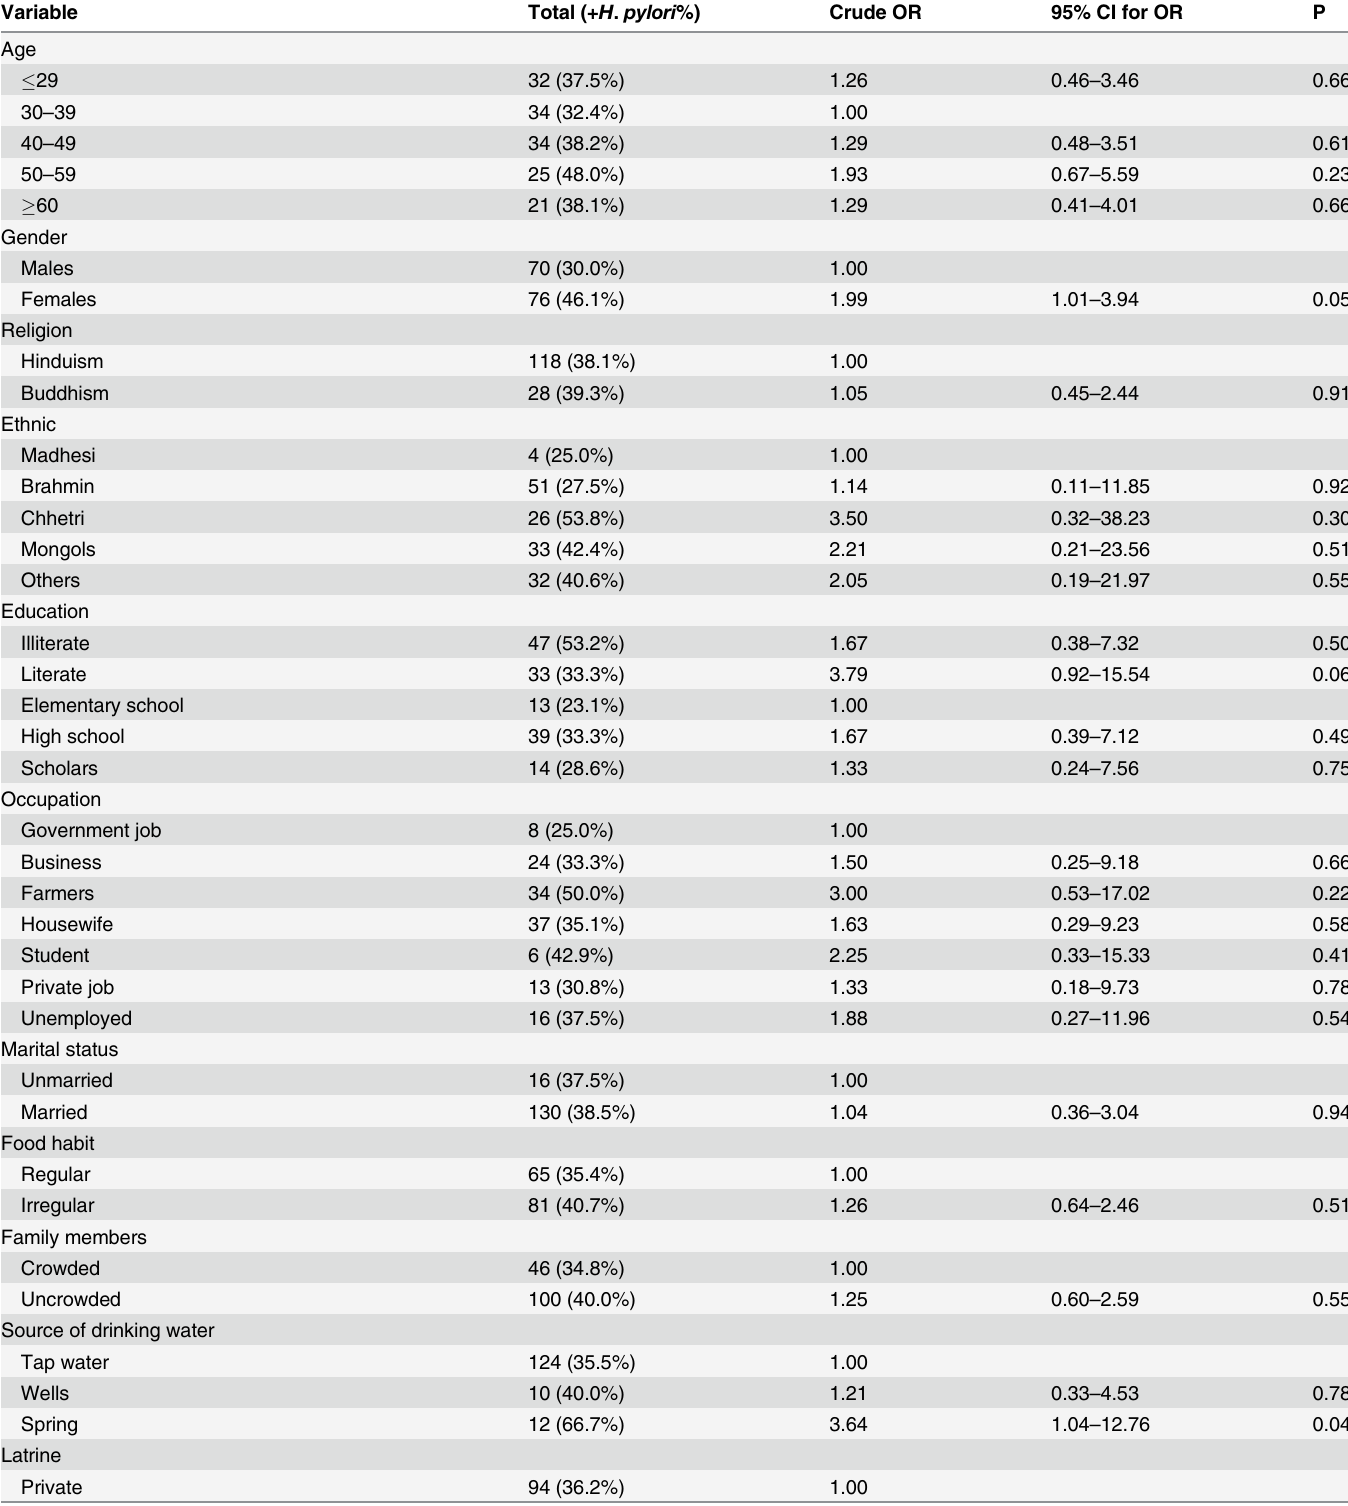
Table 1. Association of demographic, sanitation and sociocultural factors with H . pylori infection